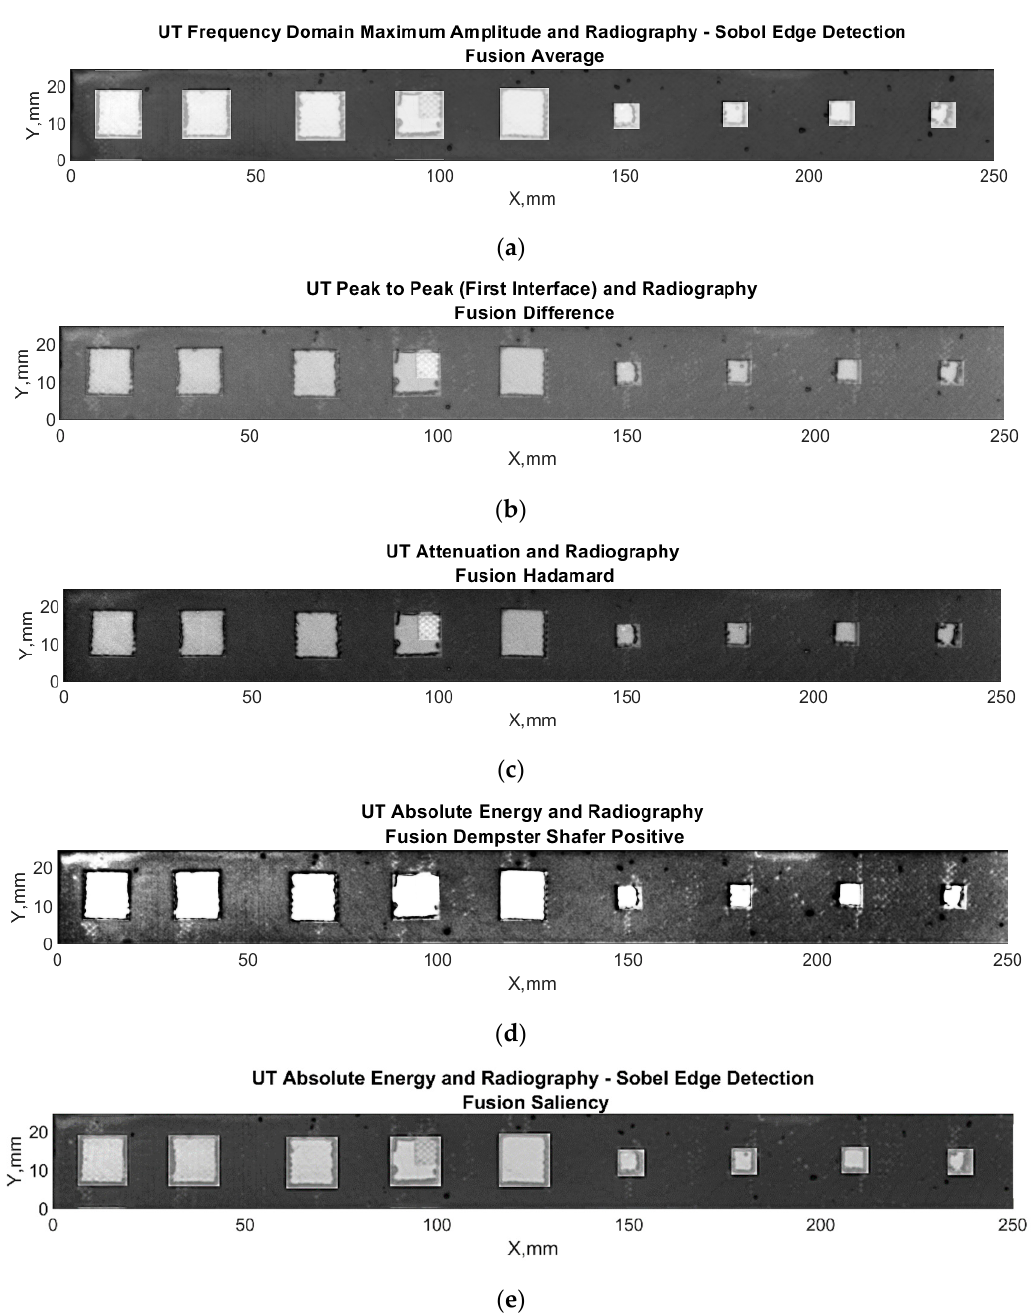
Figure 13. Examples of different combinations of fused features and used fusion algorithms: ( a ) U5X4 average; ( b ) U4X1 difference; ( c ) U2X1 Hadamard; ( d ) U6X1 Dempster Shafer Positive; ( e ) U6X4 saliency